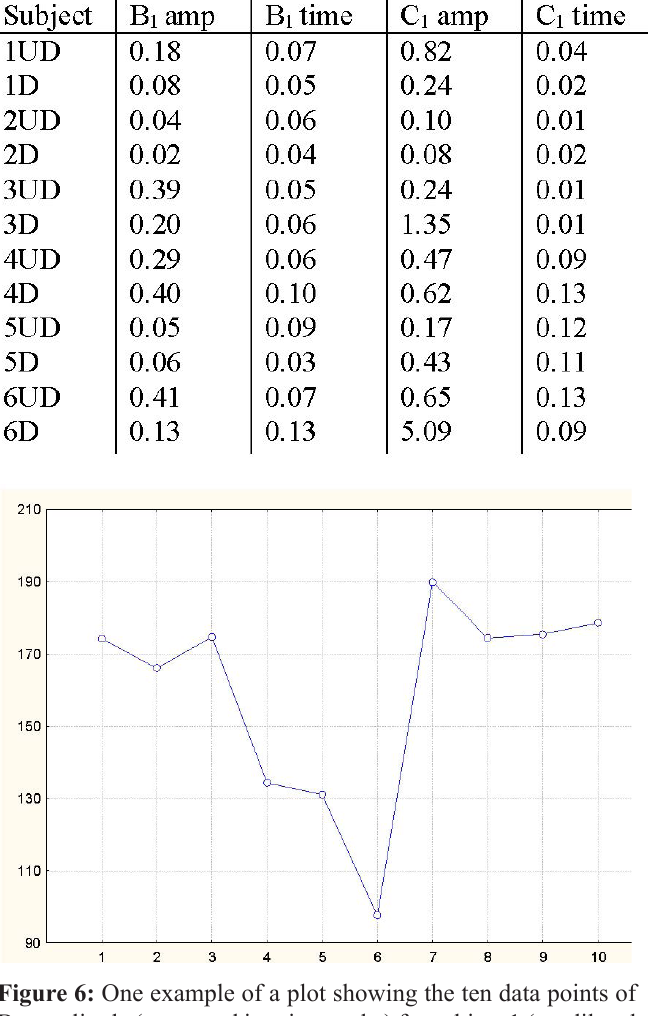
Table 5: Coefficients of variation for each subject for amplitude and implicit times.